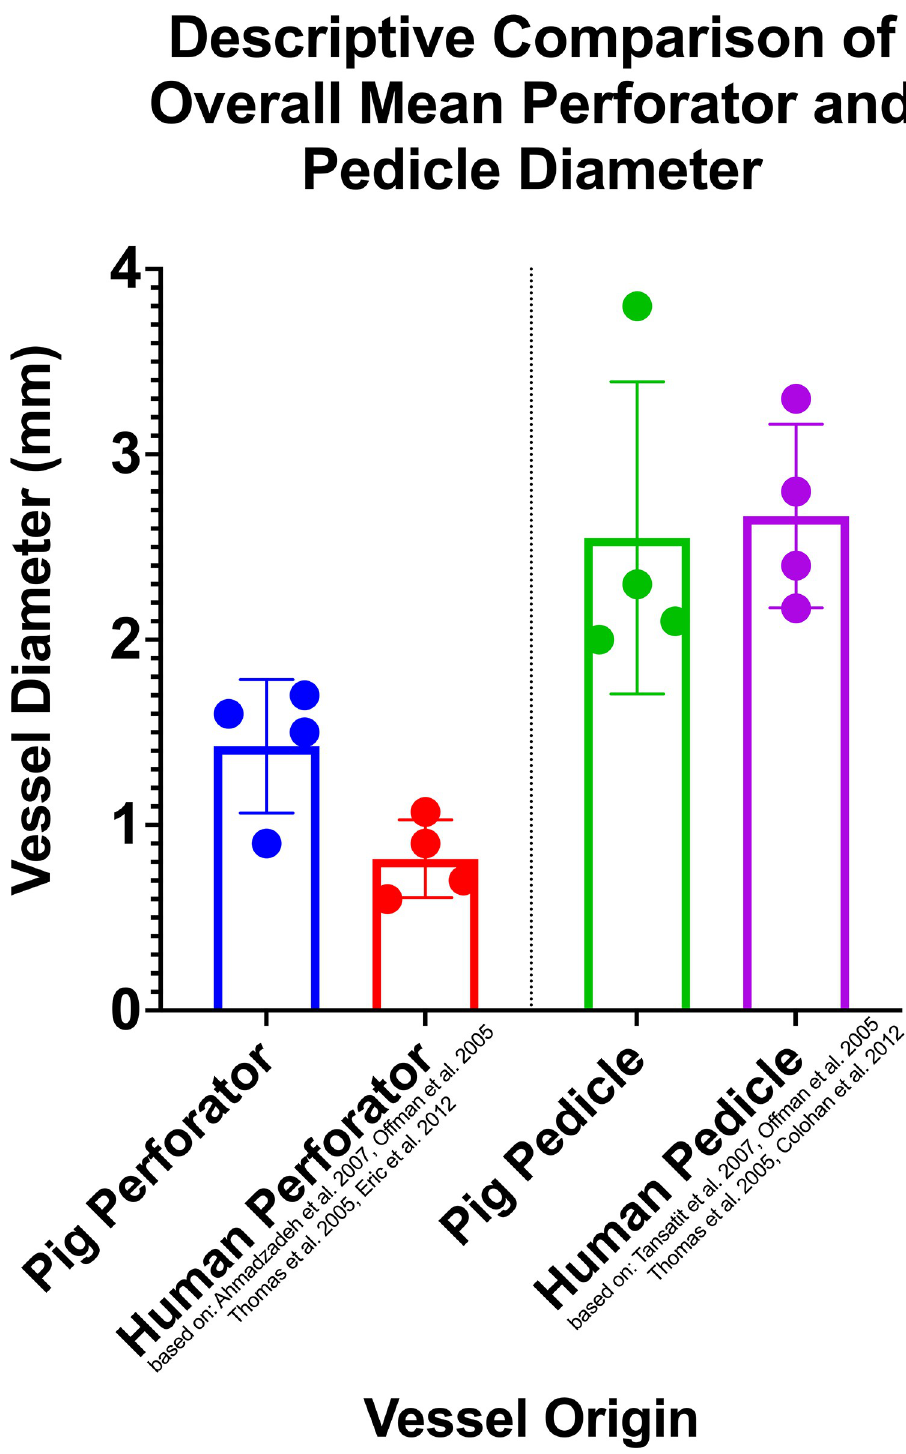
Fig 6. Descriptive overall comparison between the average diameters for all four flap types in pigs and humans. DCAPf has no human correspondent.